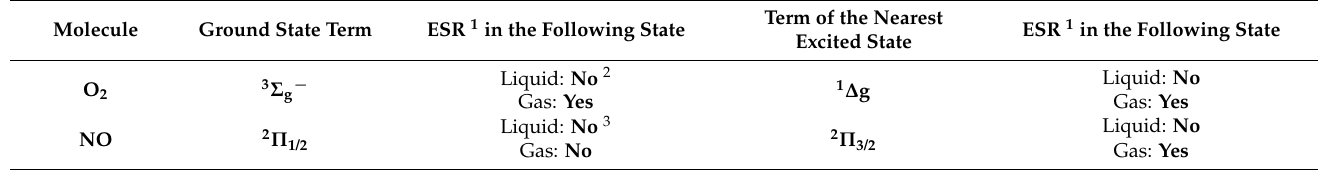
Table 1. The terms of O 2 and 2 NO in the ground and the closest in energy excited states as well as their paramagnetism in the gas and the liquid phases. Molecule Ground State Term